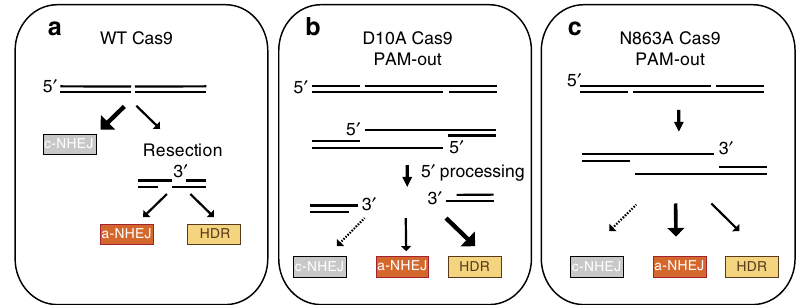
Figure 7 | Models. ( a ) Model depicting the predominant engagement of c-NHEJ for the repair of WT Cas9 induced DSBs. ( b ) Model depicting the predominant engagement of HDR for the repair of D10A Cas9-induced DSBs with gRNAs in PAM-out configuration. ( c ) Model depicting the predominant engagement of a-NHEJ/SD-MMEJ and HDR for the repair of N863A Cas9-induced DSBs with gRNAs in PAM-out